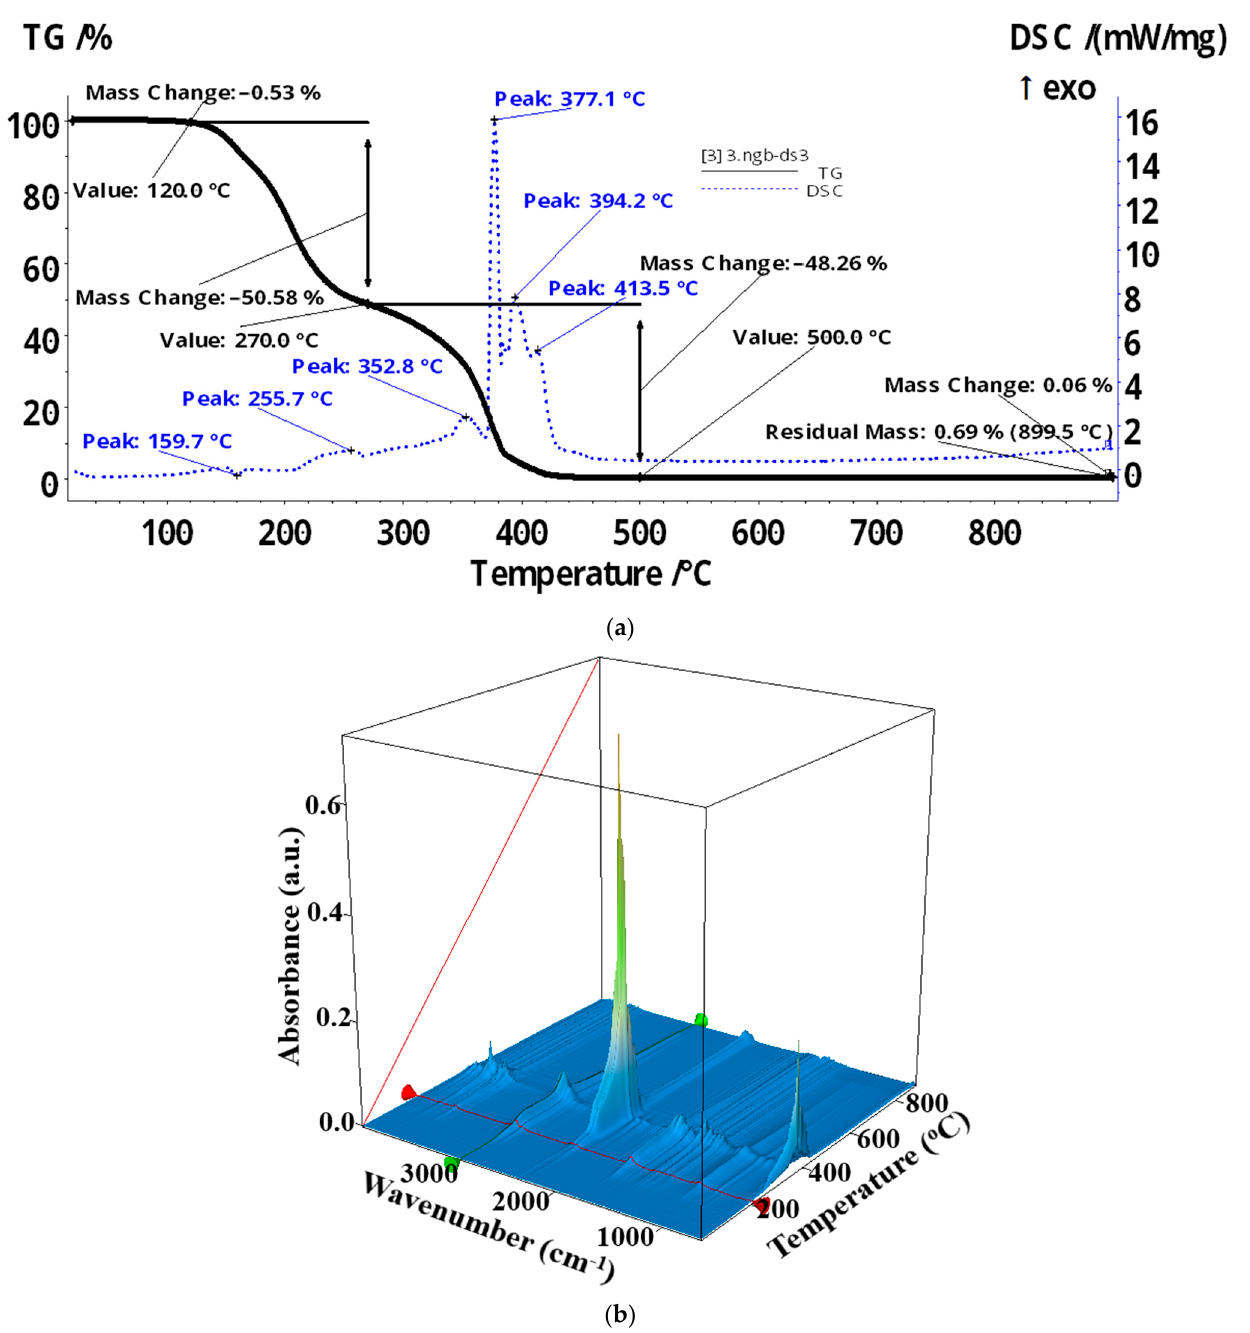
Figure 8. Thermal characteristics ( a ) and the 3D plot of FTIR spectrum vs. temperature ( b ) for the evolved gases from the Os–PPM t sample.